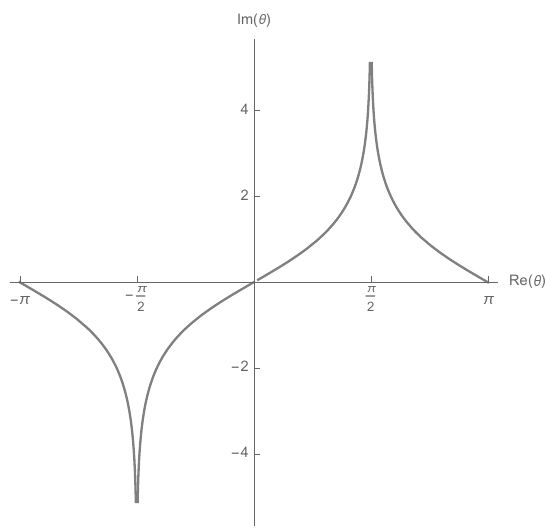
Figure 3. Integral contour of (cid:18) where Re(cos (cid:18) ) = (cid:6)